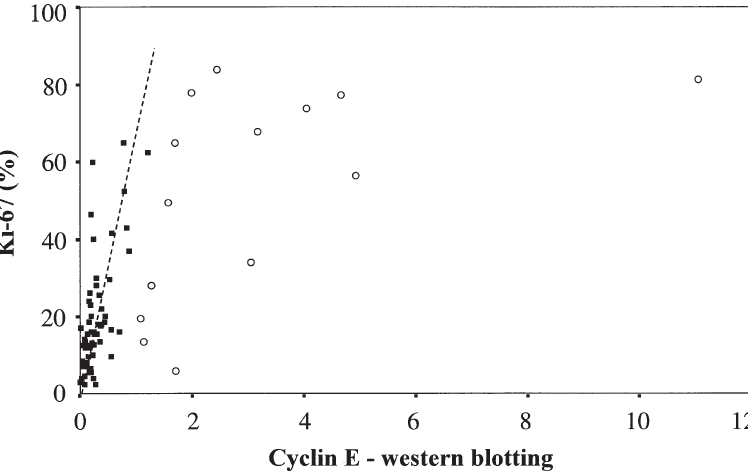
Fig. 5. Scatter plot of the percentage Ki-67 positive cells and total amount of cyclin E determined by Western blotting. Two groups of tumours are defined: one considered following a linear relationship between cyclin E expression and proliferation ( (cid:4) ), and one considered truly overexpressing cyclin E separated from an exclusively proliferation induced expression of the protein ( (cid:13) ). The regression line for the former group is